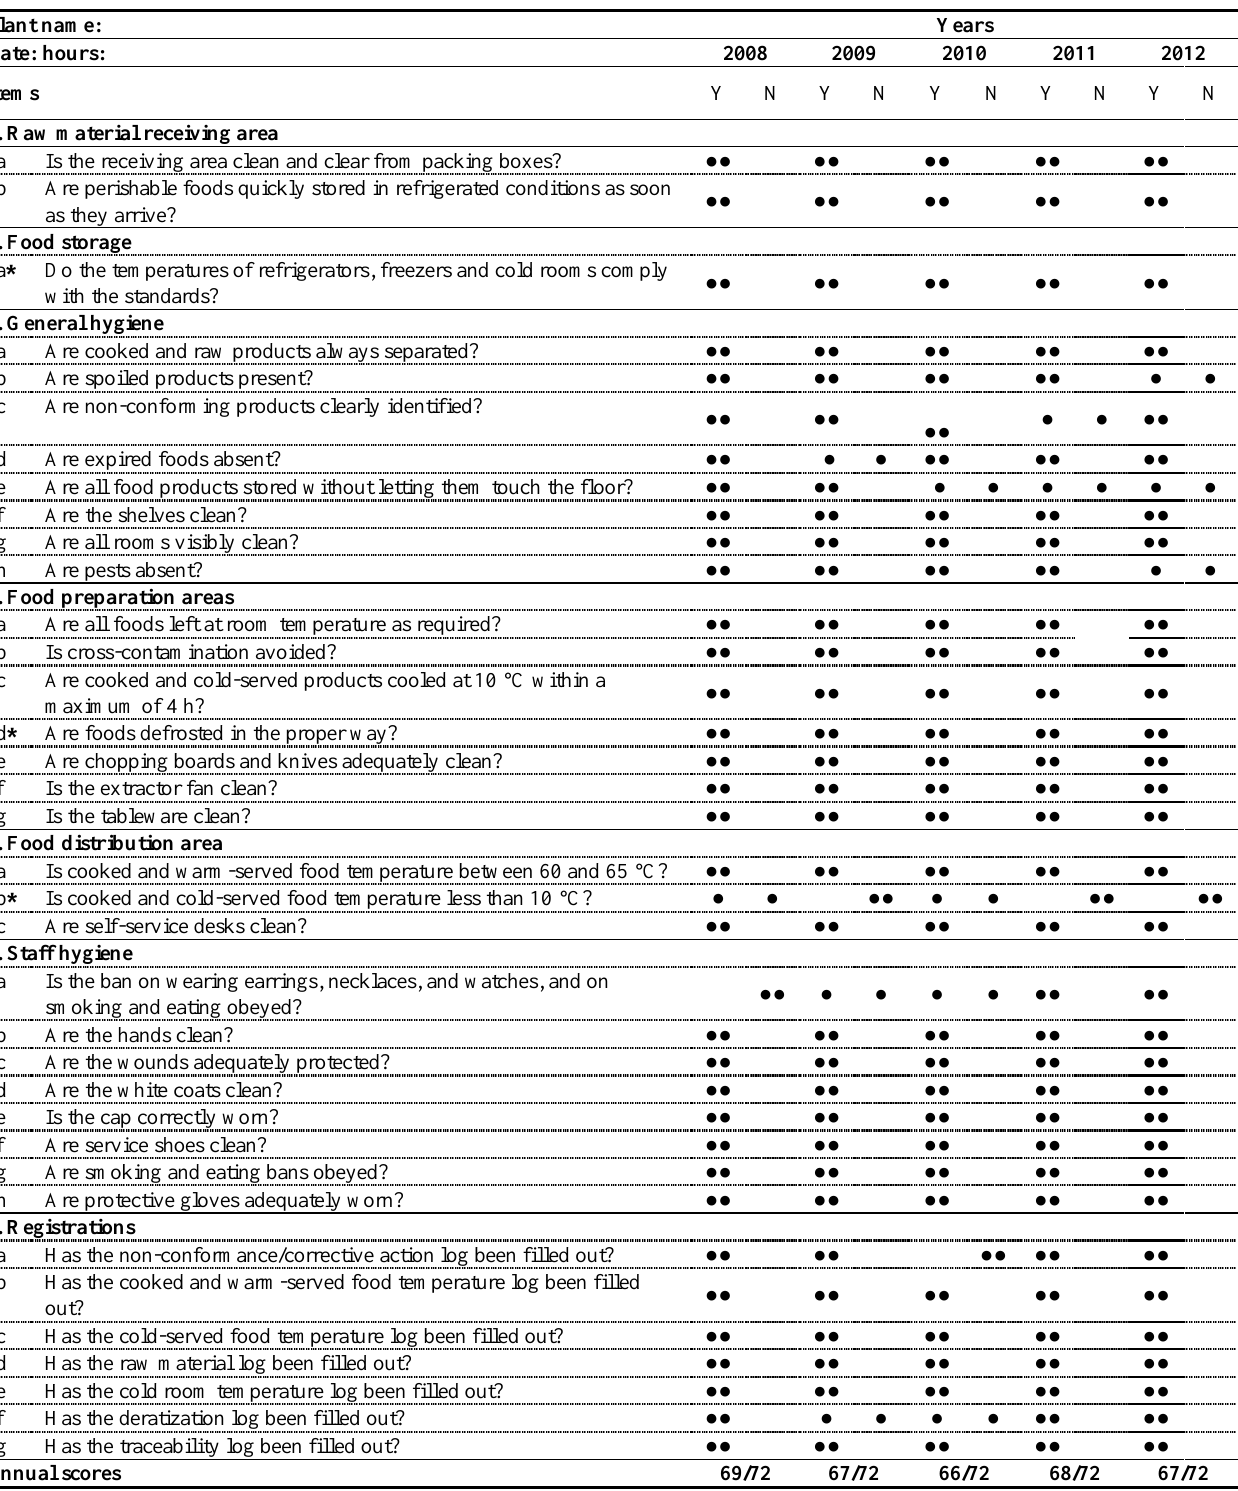
Table 2. Audit check-list and results for the attribution of non-conformances from 2008 to